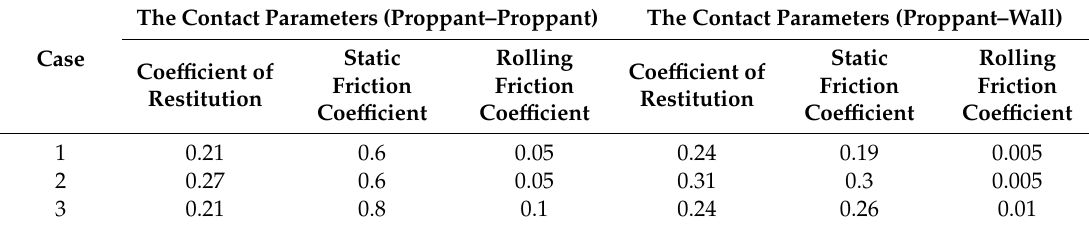
Table 8. The contact parameters of di ff erent models.